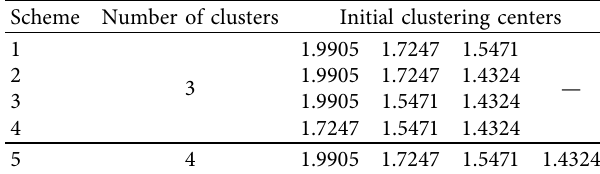
Table 3: Initial clustering centers of five clustering